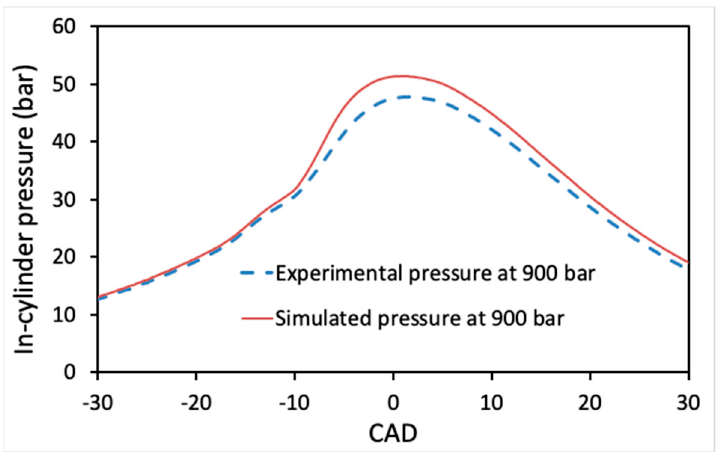
Figure 7. Comparison of the calculated in-cylinder pressure versus CAD with measured data at 1000 rpm and 900 bar.